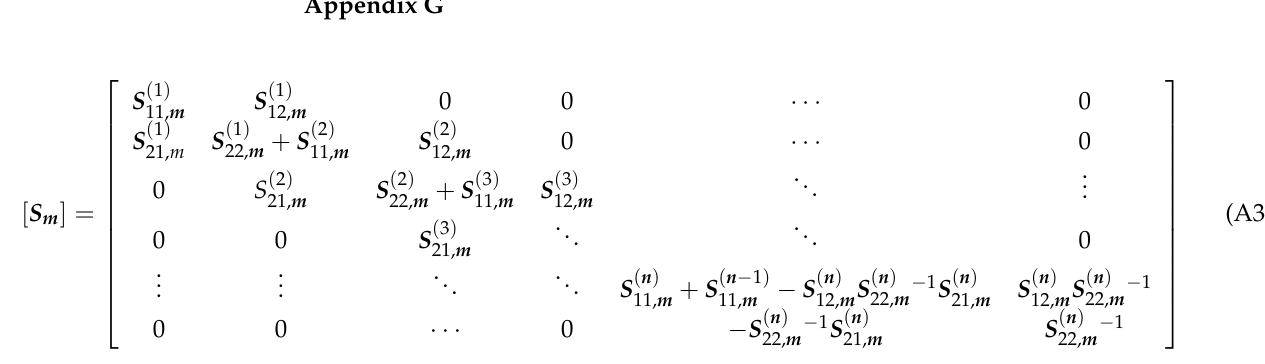
Equation (A34) is associated with Equation (58). Comparing it with the global stiffness matrix in Equation (56), only the last two submatrices in the last two rows of